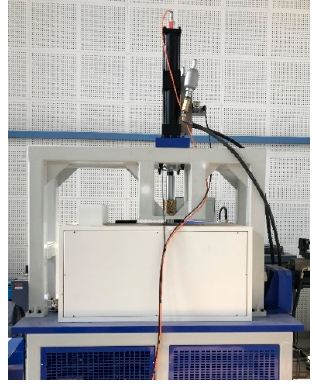
Figure 5. Material testing system with an environment box.